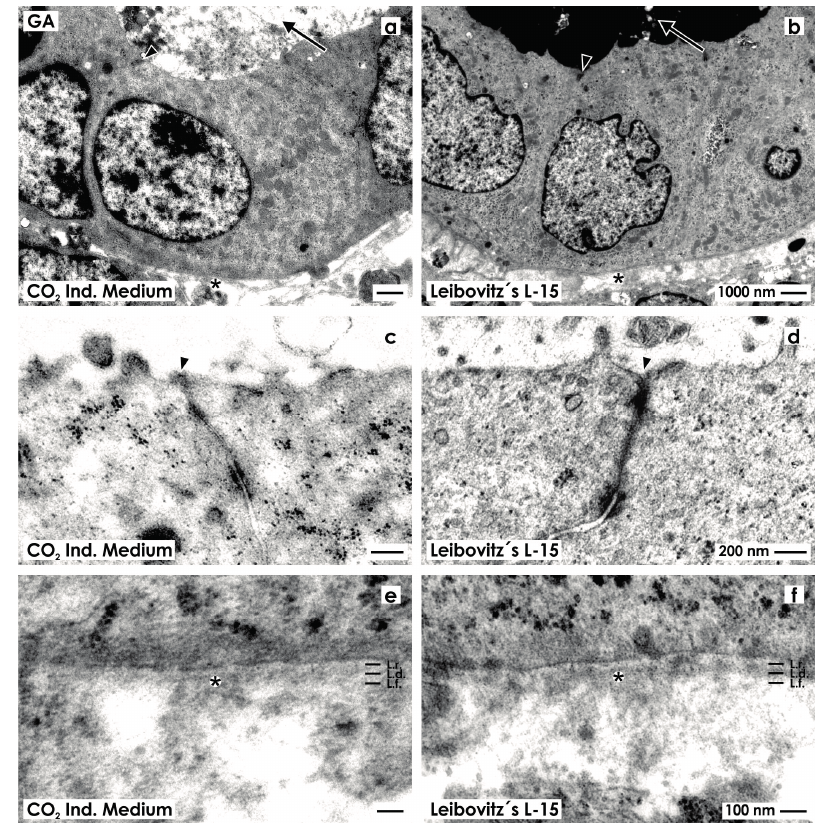
Figure 2. Transmission electron microscopy of renal tubules generated in CO 2 Independent Medium ( a , c , e ) or Leibovitz’s L-15 Medium ( b , d , f ) after fixation in conventional glutaraldehyde (GA) solution. ( a , b ) Generated tubules show a polarized epithelium with a lumen (arrow) and a basal lamina (asterisk); ( c , d ) Between the luminal and lateral plasma membranes a tight junction (arrow head) is established; ( e , f ) In both cases the established basal lamina consists of a lamina rara (L.r.), lamina densa (L.d.) and lamina fibroreticularis (L.f.). The interstitium is bright and looks